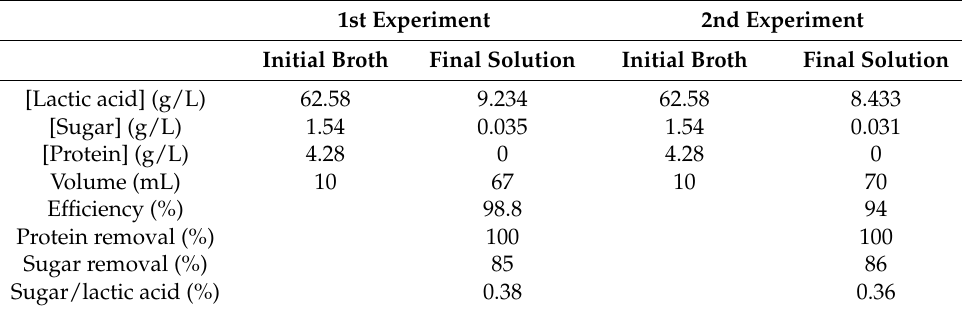
Table 8. Results of purifications using charcoal with